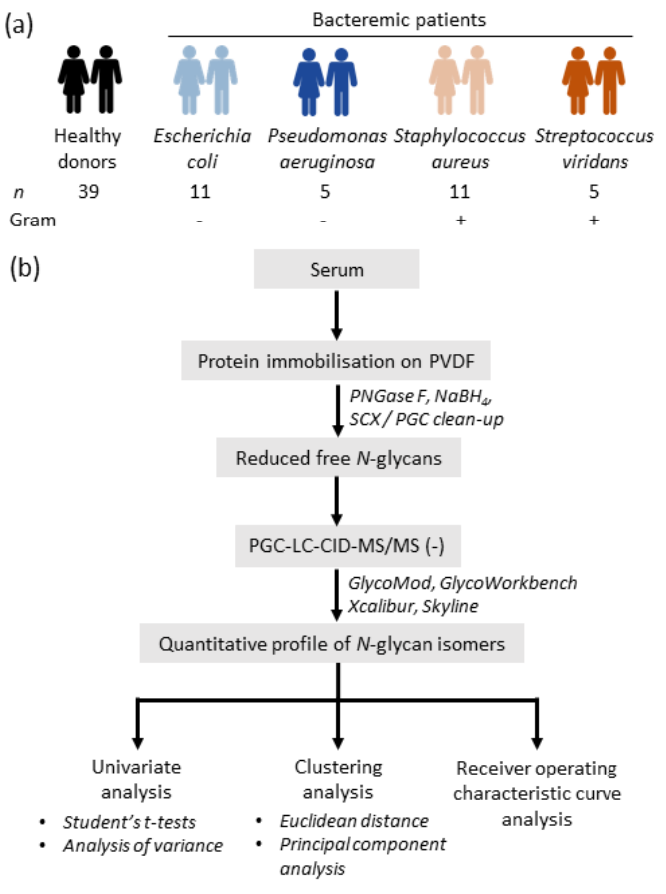
Figure 1. Study design. Overview of the ( a ) investigated cohort comprising four groups of bacteremic patients infected with different pathogens and a healthy control group and ( b ) the experimental workflow. Quantitative N -glycome profiling was performed of the bacteremic and healthy donor sera using an established glycomics method [52] and statistical analyses were applied to the gly- comics data. NaBH 4 , sodium borohydride; PGC-LC-CID-MS/MS, porous graphitized carbon liquid chromatography collision-induced-dissociation tandem mass spectrometry; PNGase F, peptide- N - glycosidase F; PVDF, polyvinylidene fluoride; SCX, strong cationic exchange.